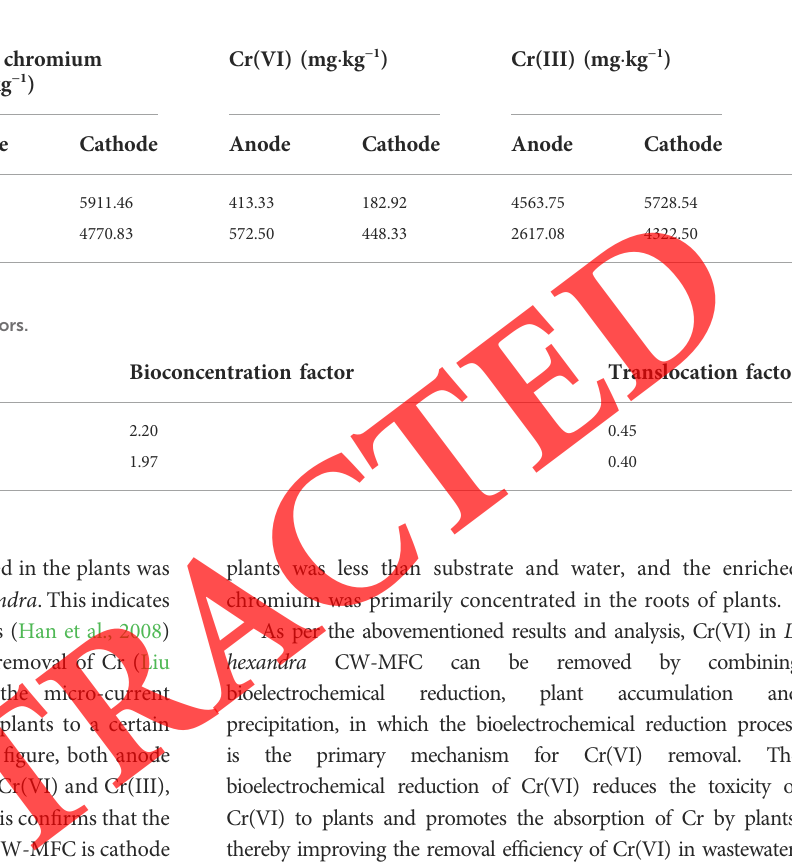
TABLE 2 Cr concentrations in the substrates.